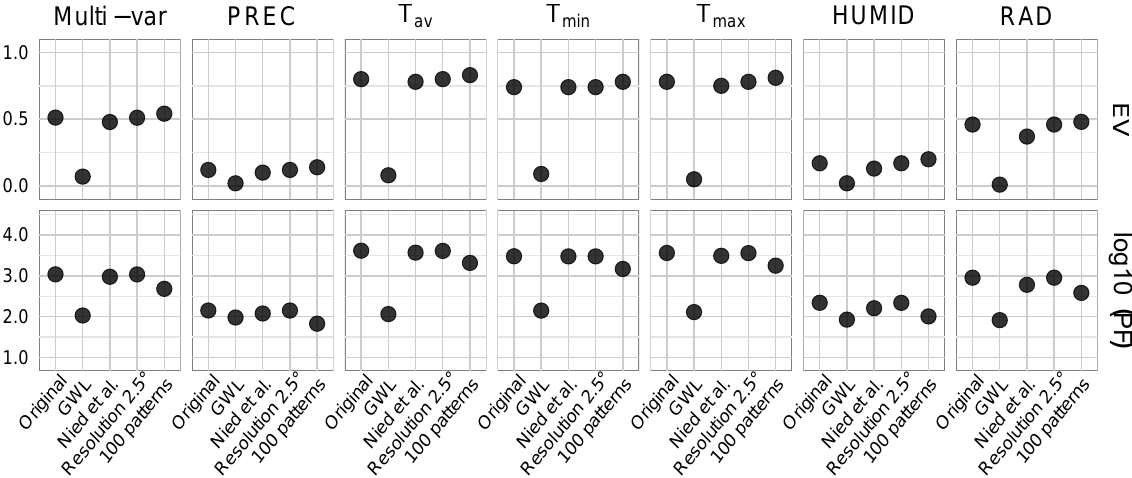
Figure 6. Comparison of selected classification from Sect. 4.1.1 (original) and other classifications: Hess–Brezowsky Grosswetterlagen (GWL), classification variables as in Nied et al. (2014), a classification on a coarse grid, and one with 100